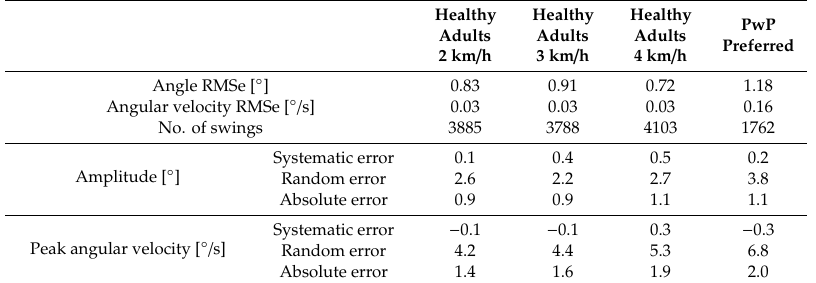
Figure 3. The angle of the inertial measurement unit (IMU) and optical data of a healthy participant and of a patient with Parkinson’s disease. Table 2. Error measures of IMU-derived arm swing data, compared to optical system-derived